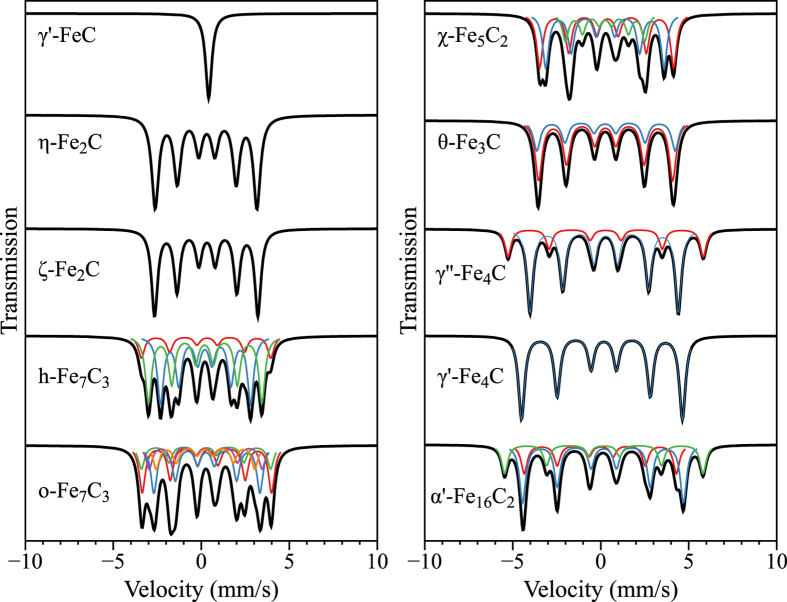
The predicted Mössbauer spectroscopy of γ′-FeC, η-Fe2C, ζ-Fe2C, h-Fe7C3, o-Fe7C3, χ-Fe5C2, θ-Fe3C, γ′-Fe4C, γ″-Fe4C, and α′-Fe16C2.